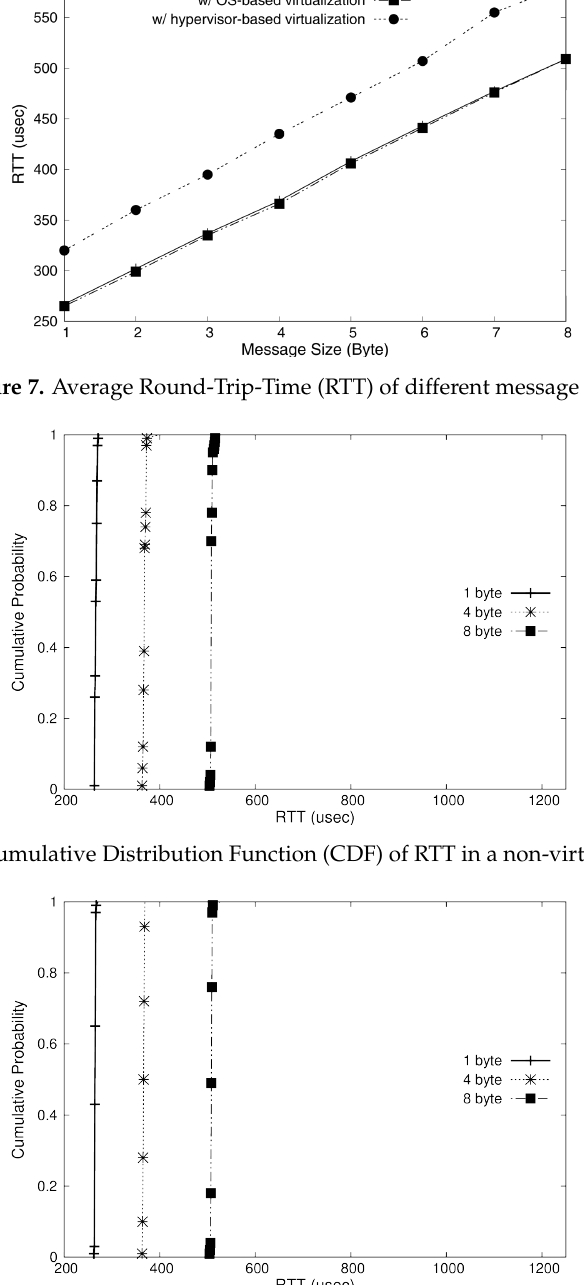
Figure 9. CDF of RTT in an operating-system(OS)-based virtualization